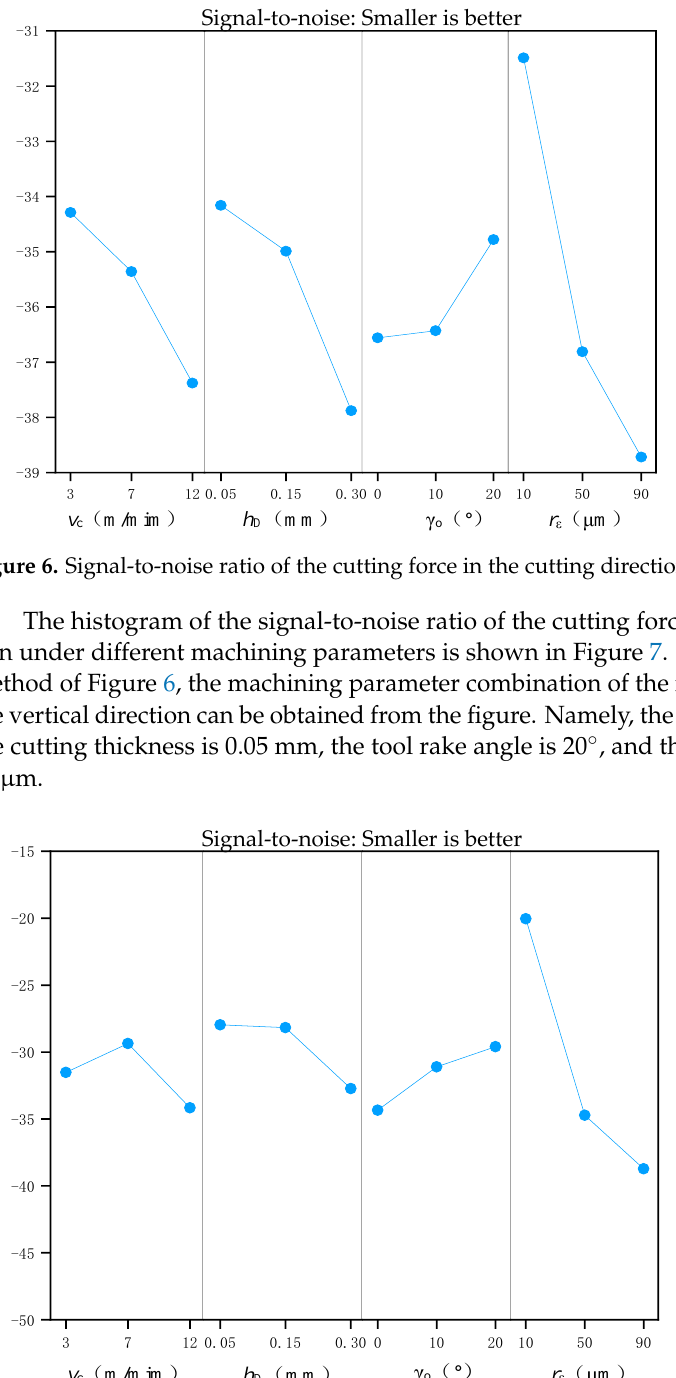
Signal-to-noise: Smaller is better